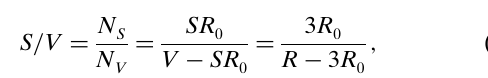
Table 1 Lattice parameters ( a , c ), average NP size ( D ), unit-cell volume ( V ),